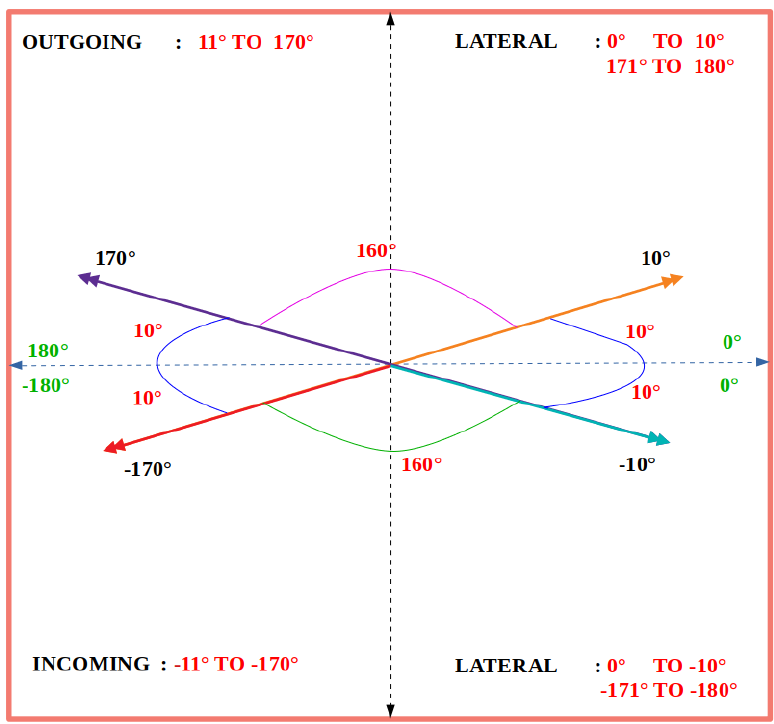
Figure 14. Degree ranges used to classify PIV vectors as lateral, incoming, and